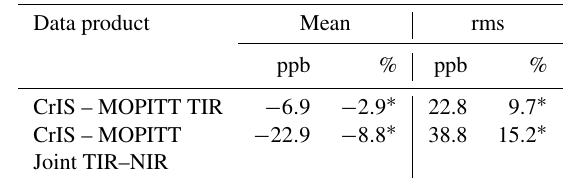
Table 3. The differences of carbon monoxide volume mixing ra- tio in the lower troposphere (surface to 3km ( ∼ 700hPa)) between CrIS and MOPITT measurements shown in Fig. 3a.